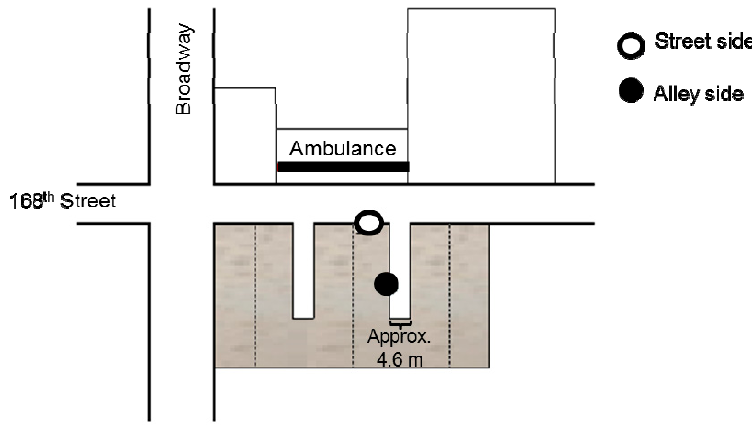
Figure 1. Central site monitor placement: street vs. alley side windows of the same NYC apartment unit. Note: The alley ( ) monitor was nine meters away from the street monitor ( ) and approximately 4.6 meters away from adjacent building.